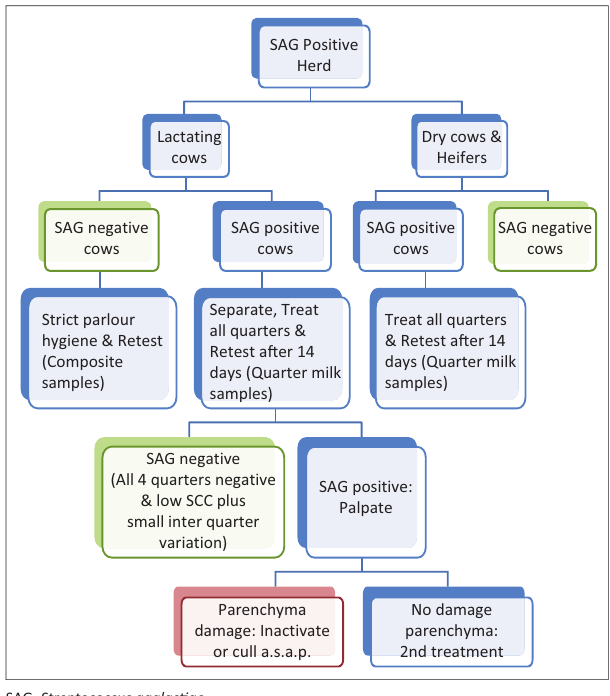
FIGURE 1: A flow chart indicating events during the management of a Streptococcus agalactiae intra-mammary infection outbreak in a dairy